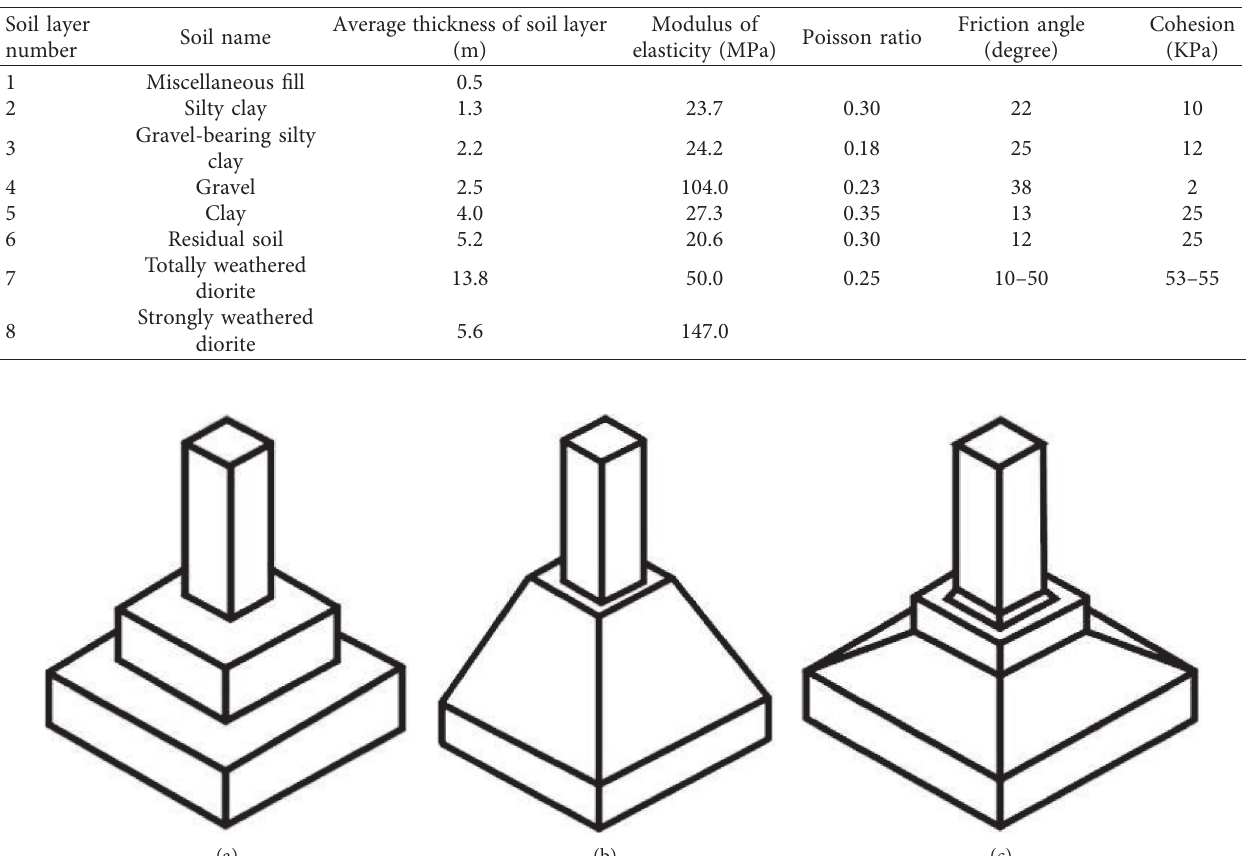
Table 1: Site soil parameters based on-site engineering geological conditions and surrounding environmental conditions.